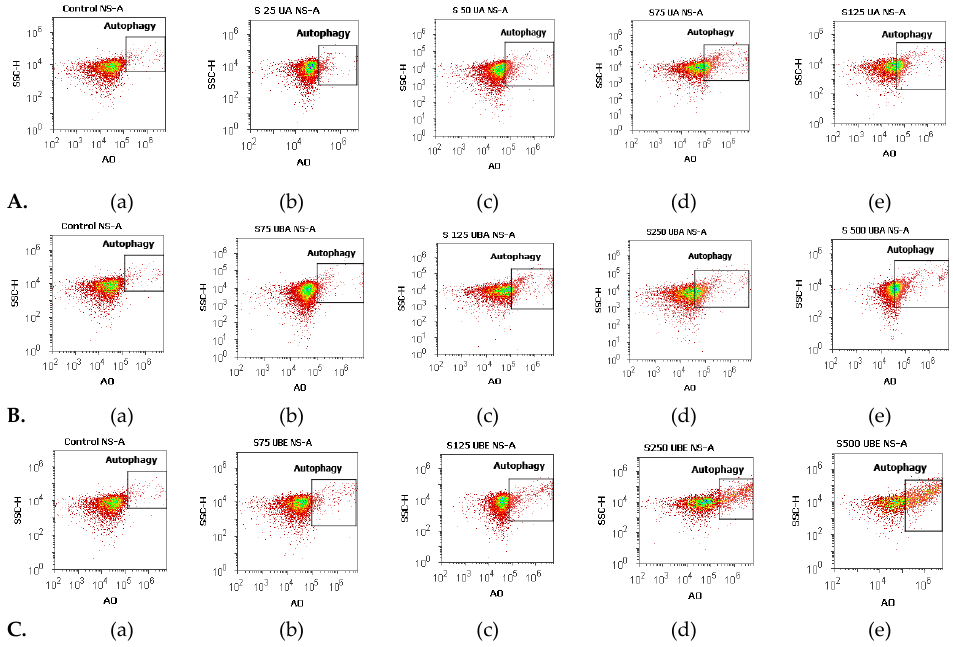
Figure 7. Autophagy status of UBA, UBA, and UBE treatments in normal blood cell cultures. Acridine orange patterns of UA 25, 50, 75, 125 μ g/mL A ( b – e ); B ( b – e ) UBA 75, 125, 250, 500 μ g/mL; C ( b – e ) UBE 75, 125, 250, 500 μ g/mL reported to 1% DMSO ( A ( a ), B ( a ), C ( a )).